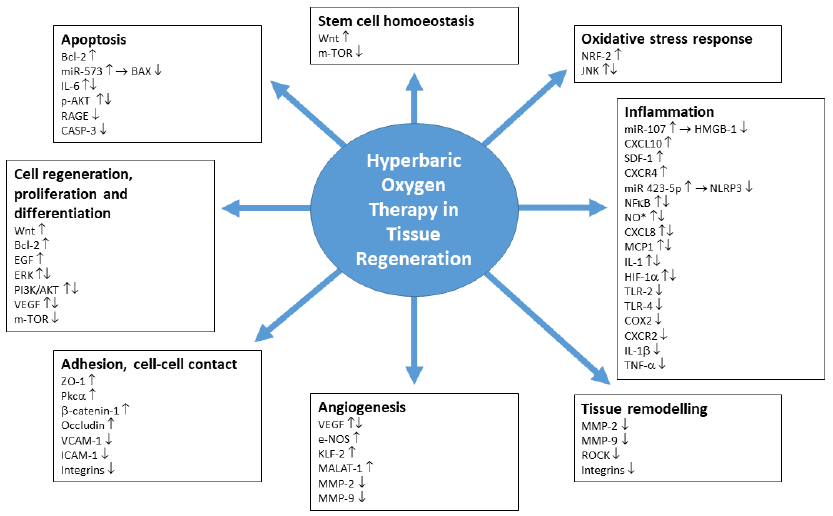
Figure 1. Main points of action of HBO in tissue regeneration.